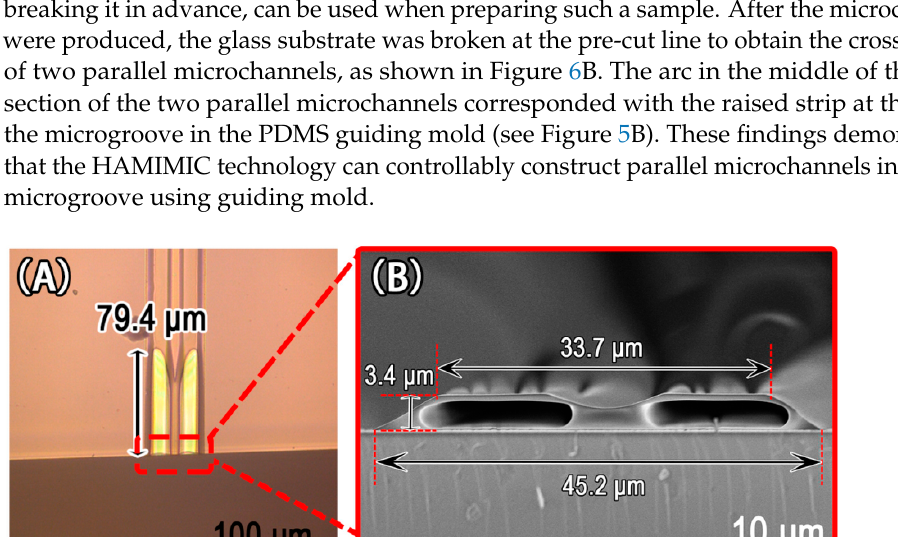
Figure 6. Images of two parallel microchannels fabricated with a PDMS guiding mold: ( A ) surface microscope photograph; ( B ) SEM image of the cross-section.